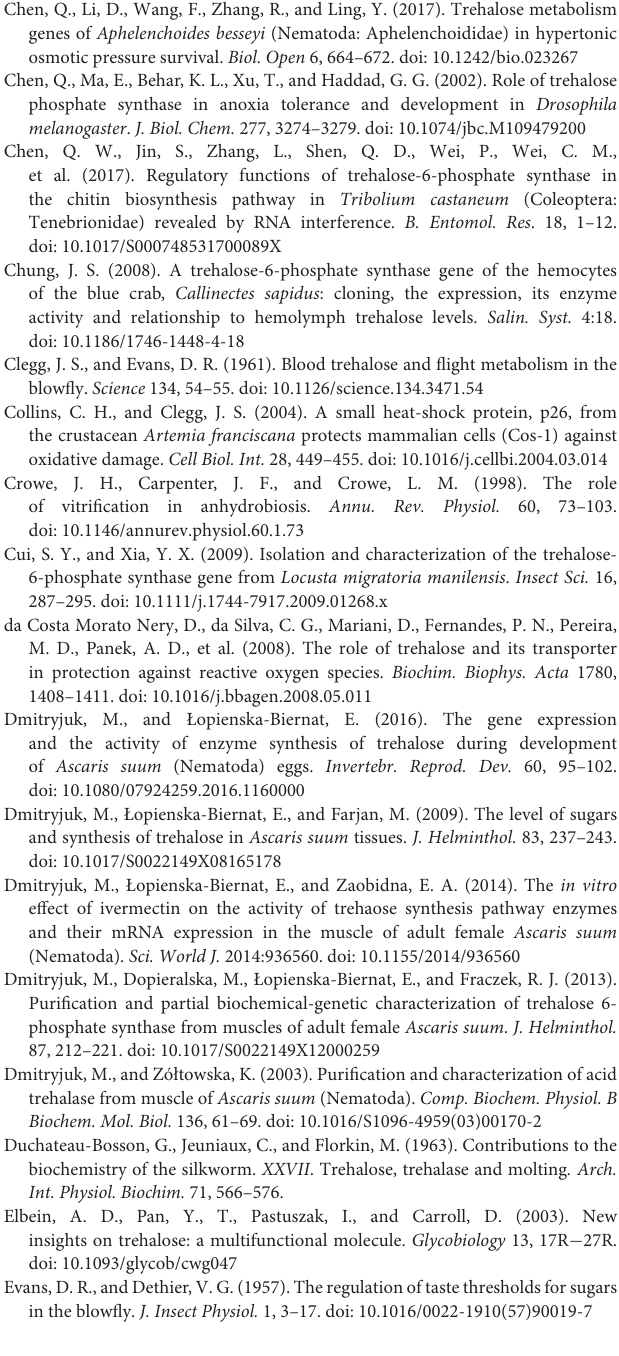
genes’ analysis: SW, H-JW, and BT. Sequence data analysis and figure drawing: BT and J-YZ. Wrote the paper: S-YC and